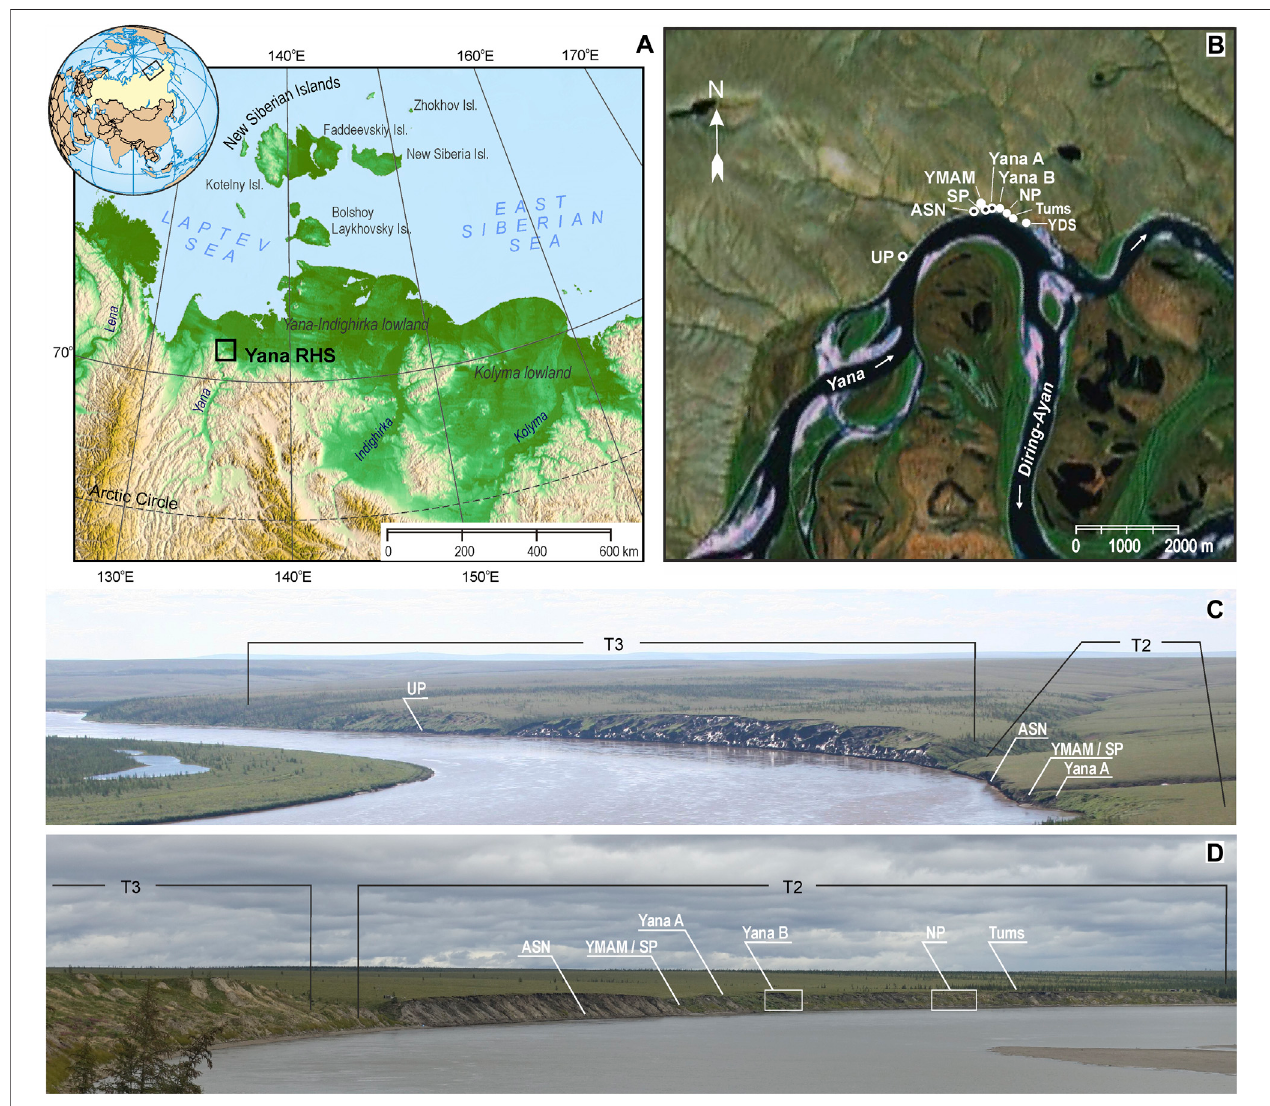
FIGURE 1 | The Yana RHS site location and relationship between its structural elements: (A) – westernmost part of the late Pleistocene arctic Western Beringia (a fragmentofETOPO1GlobalReliefModelimageisused); (B) – schematicmapofthearea(afragmentofGoogleEarthsatelliteimageisused.Whitecirclesmarklocalities thatretainculturalmaterial insitu – YanaB,NorthernPoint(NP),Tums1,YanaDownstreamPoint(YDS),andYanamassaccumulationofmammoth(YMAM);circleswith blackcentermarklocalitiesthatyieldedsurface fi nds:UpstreamPoint(UP),ASN,YanaA,andSouthernPoint(SP); (C) – extentofthesecond( T 2)andthethird(T3) terrace, and location of archaeological objects on the left riverbank of the Yana river viewed from the East and (D) – archaeological objects of the left riverbank viewed from southwest respectively.